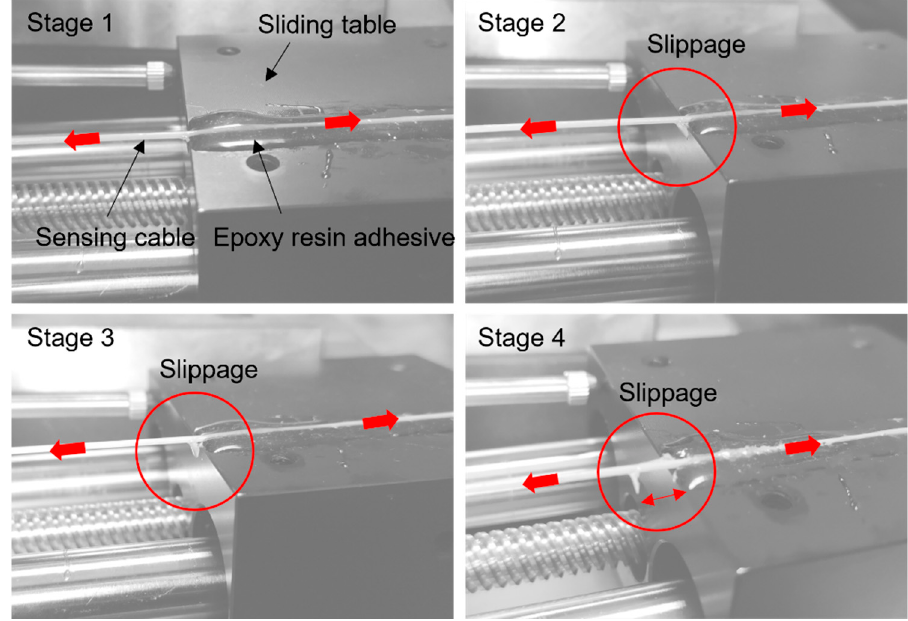
Figure 11. Sensing cable slippage from the cured